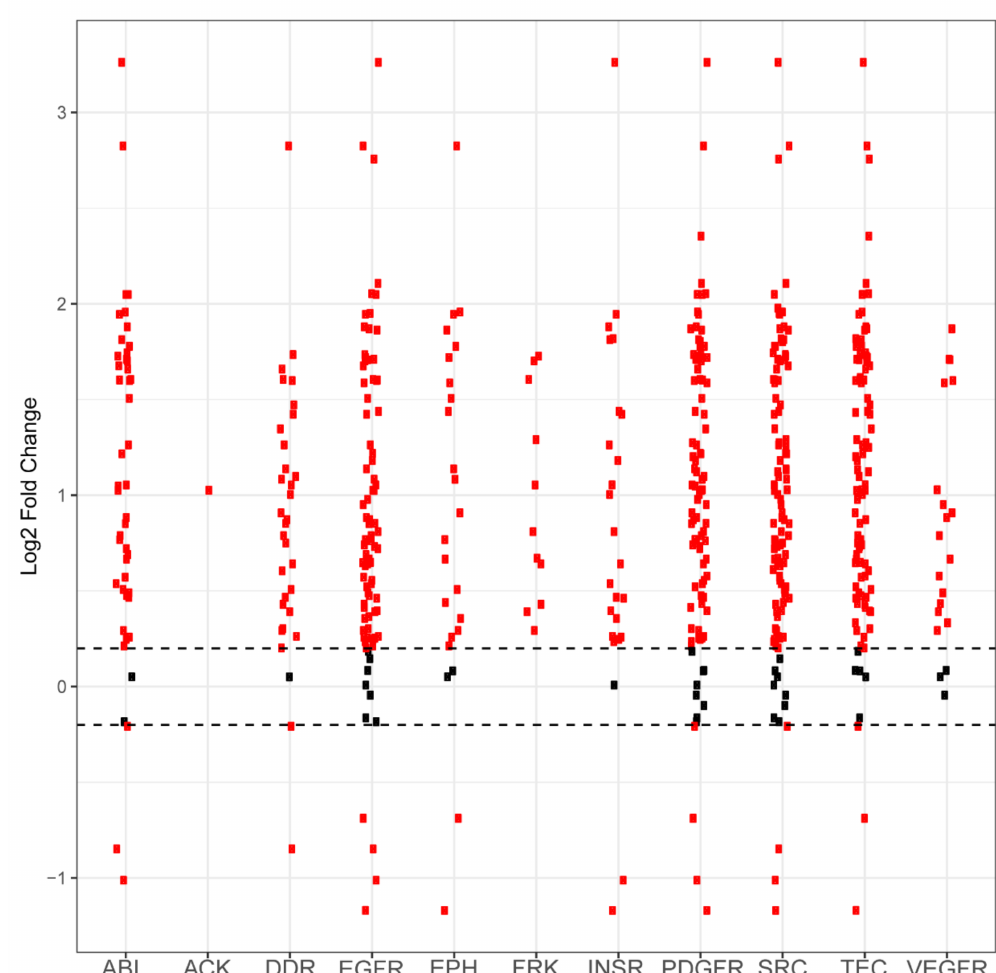
Figure A1. Di ff erential phosphorylation levels of peptide sequences attributed to kinase family activity in PANC1 vs. wild-type control. Each red dot in a column represents one peptide sequence whose phosphorylation is performed by that column’s kinase family. The y axis reports log2-fold change and the x axis identifies the kinase family. Black dots represent peptides that did not demonstrate di ff erential phosphorylation in PANC1 samples compared to wild-type samples, with the dashed horizontal line representing a positive or negative 0.2 log2-fold change cuto ff . Red dots above these lines represent peptides that are more phosphorylated in PANC1 compared to control. Red dots that are below these lines represent peptides that are less phosphorylated in PANC1 compared to